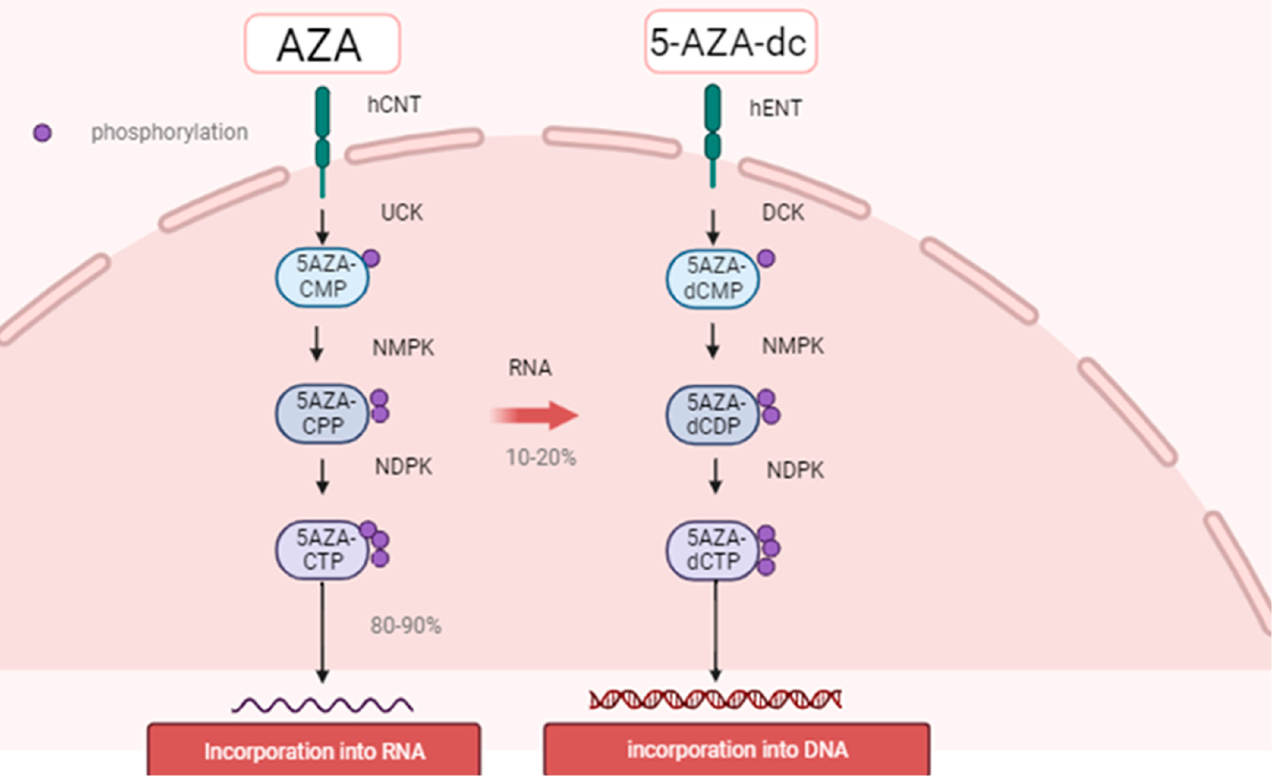
diphosphate, CMP cytidine monophosphate, hCNT human concentrative nucleoside transporter, hENT human equilibrative nucleoside transporter, NDPK nucleoside diphosphate kinase, NMPK nucleoside monophosphate kinase, and RNR ribonucleotide reductase, and azanucleoside (AZA) uptake and intracellular metabolism. Once inside the cell, the drugs are activated through consecu- tive ATP-dependent phosphorylation steps.